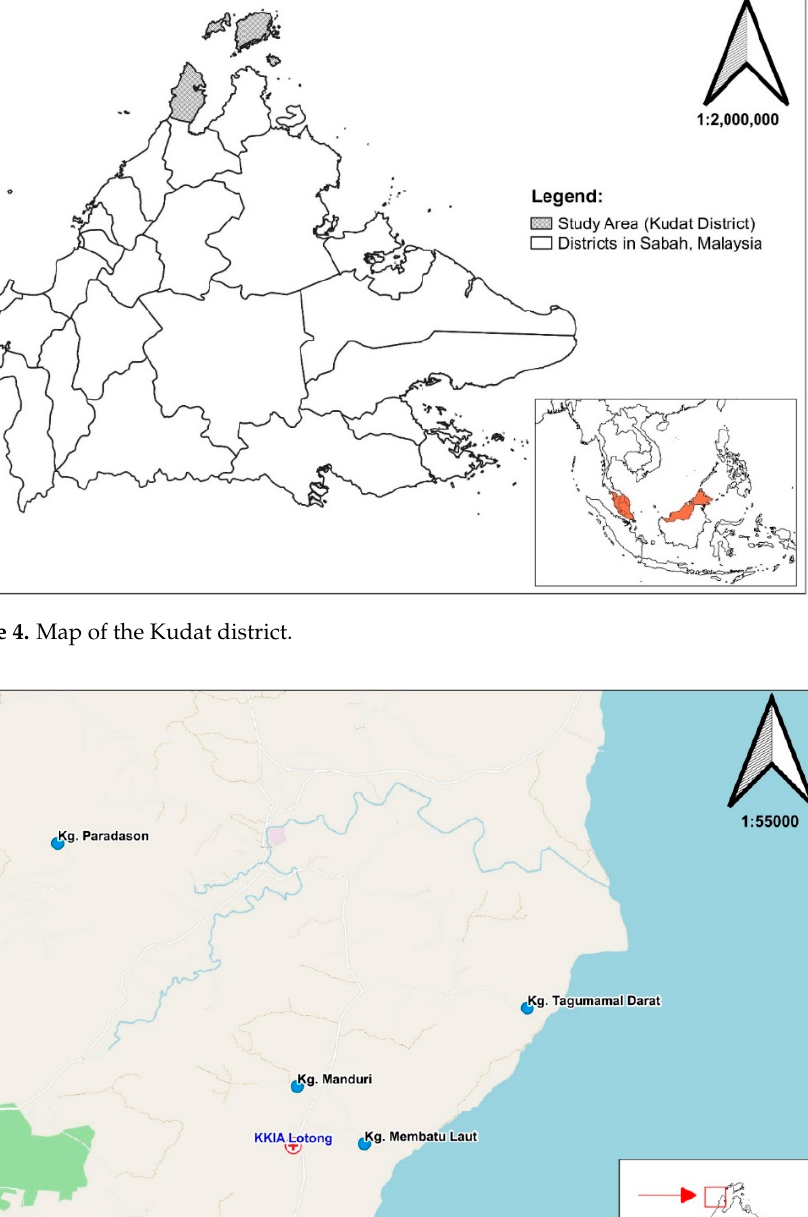
Figure 5. The study sites.